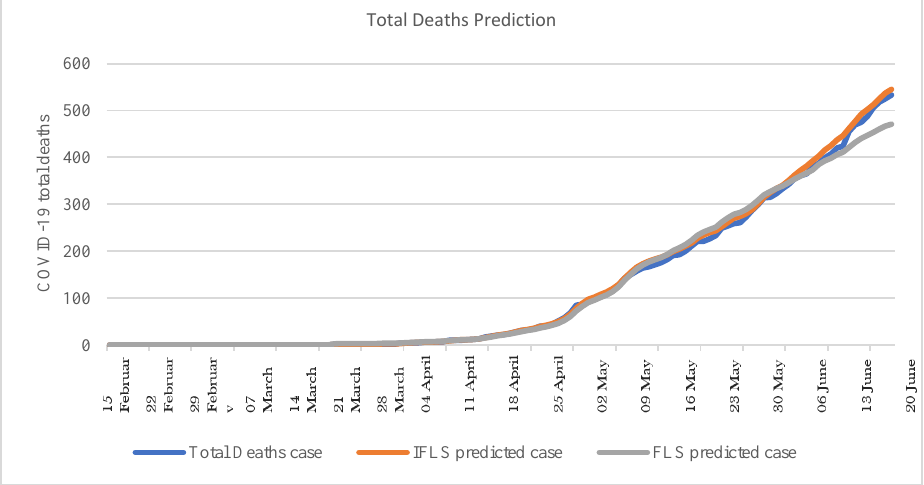
Fig. 9. Graph showing actual and predicted values of total deaths from